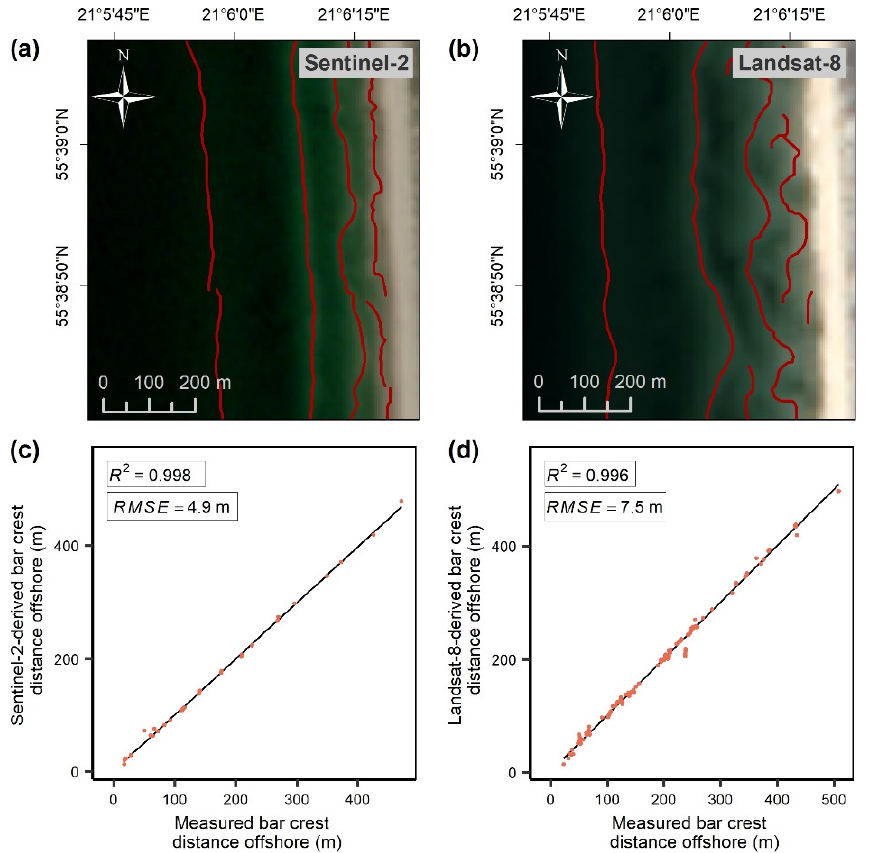
Figure 12. An example of sandbar crestlines delineated using the proposed method in Sentinel-2 MSI ( a ) and Landsat-8 OLI ( b ) images with a correlation of measured and extracted crest distance from the shoreline ( c , d ) during low wave energy conditions.